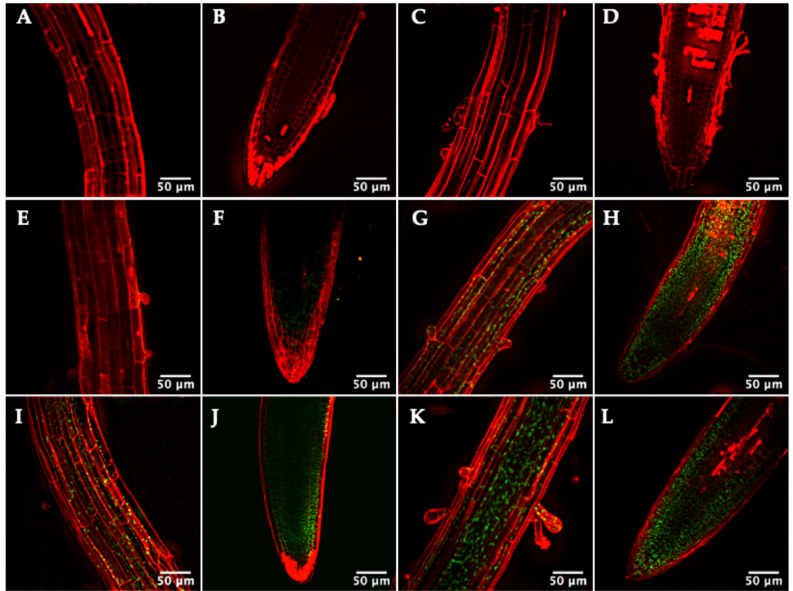
Figure 4. Representative confocal images of Arabidopsis lines expressing the TRX( f/m )::GFP con- structs in roots of 7-day-old Arabidopsis seedlings. ( A , B ) TRX f1 , ( C , D ) TRX f2 , ( E , F ) TRX m1 , ( G , H ) TRX m2 , ( I , J ) TRX m3 , ( K , L ) TRX m4 . ( A , C , E , G , I , K ) Mature part of the root and ( B , D , F , H , J , L ) root meristem. Images show an overlay of GFP (green) and propidium iodide staining (red) fluorescences. 3.2. Photosynthesis, Stomatal Conductance and Transpiration of the TRX Mutants Photosynthetic rate ( A ), transpiration ( E ) and stomatal conductance ( g s ) were measured on attached leaves of Arabidopsis loss-of-function lines trxf1 , trxf2 , trxm1 , trxm2 , trxm3 and trxm4 by using an open IRGA system (Figure 5).